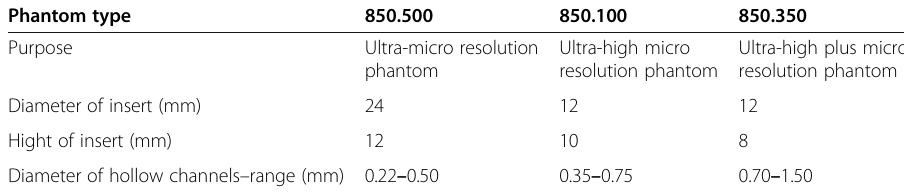
Table 2 Specifications of the used phantoms Phantom